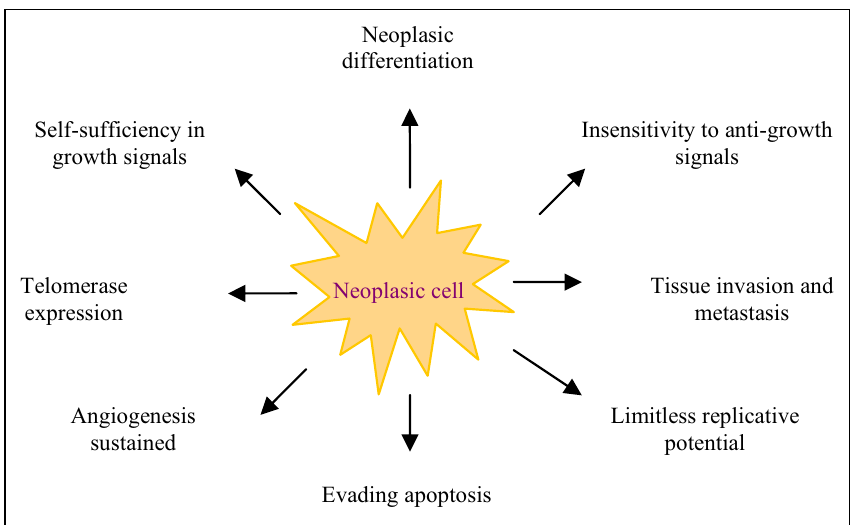
Fig. 1 – Malignant cell